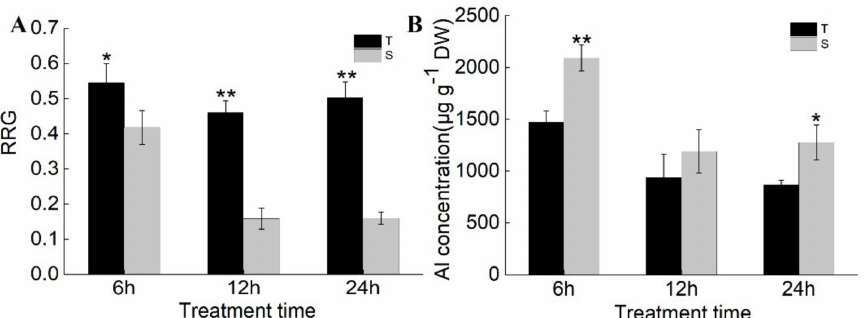
Figure 1. Phenotypic difference in Al tolerance between Al-tolerant (KF) (T) and Al-sensitive (GF) (S) soybean varieties. ( A ) Relative root growth (RRG) of T and S at 6, 12, and 24 h under Al stress (25 µ M AlCl 3 , pH = 4.3) compared to control (0 µ M AlCl 3 , pH = 4.3). Means and standard errors were calculated from three biological replications, with six plants per replication. ( B ) Al accumulation in the root tips (0–10 cm) of T and S at 6, 12, and 24 h after exposure to 25 µ M AlCl 3 (pH = 4.3). Means and standard errors were calculated from three biological replications, with over 50 plants per replication. DW: dry weight. * and ** indicate significant difference (student’s t -test) between T and S for each time point at levels of 0.05 and 0.01,